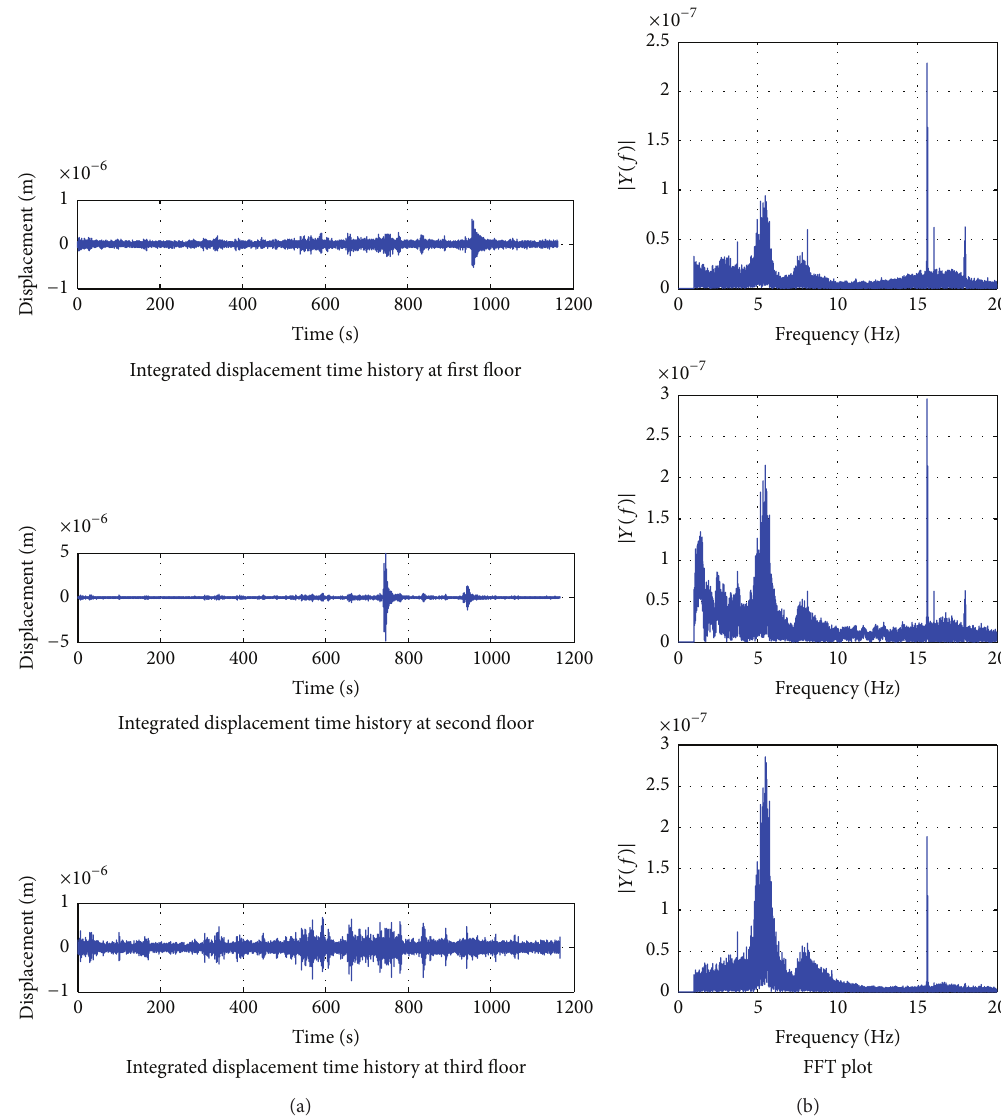
Figure 16: (a) Integrated displacement time histories at each floor in E-W direction and (b) their fast Fourier transformation (FFT) plots.